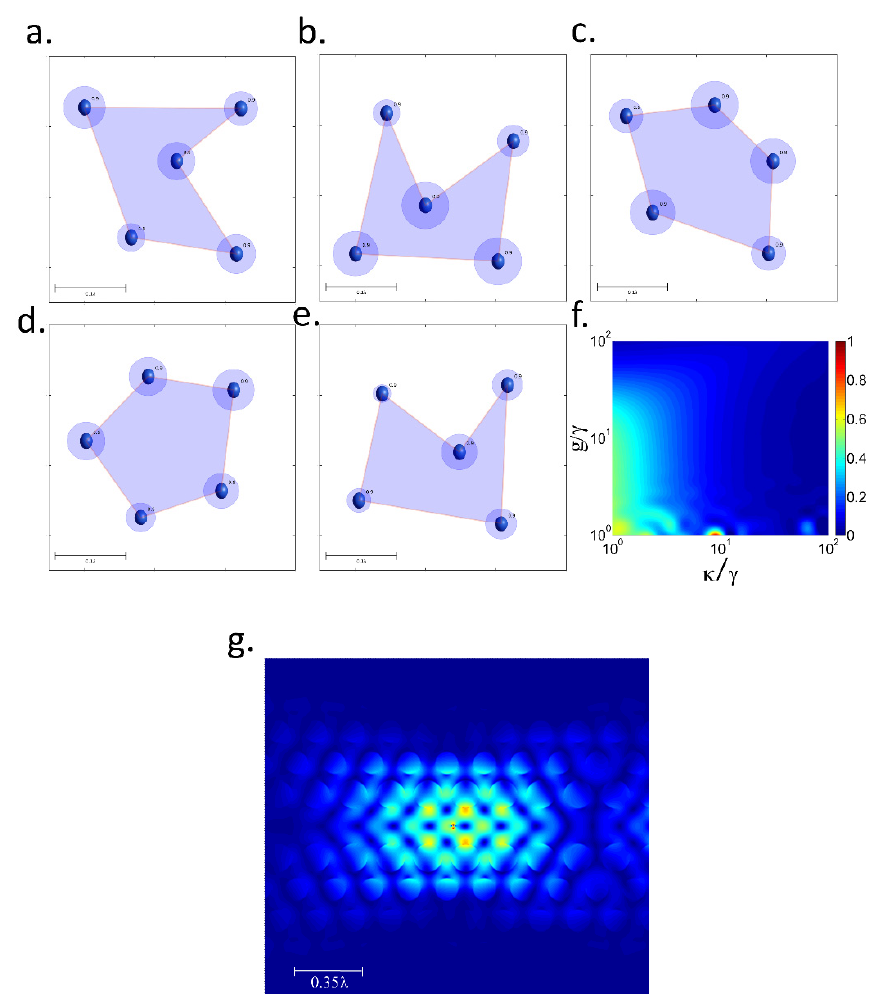
Figure 3. ( a ) Optimal configuration of the 5-QEs system in a 2D plane for ( a ) 𝜅 = 10𝛾 , ( b ) 𝜅 = 50𝛾 , ( c ) 𝜅 = 100𝛾 , ( d ) 𝜅 = 500𝛾 and ( e ) 𝜅 = 1000𝛾 . The circles around each QE position corresponds to the positioning tolerance for having I > 0.9. ( f ) Indistinguishability versus normalized 𝜅 and g for the optimized system shown in ( a ). ( g ) Field profile |𝐸| (cid:2870) of the hexagonal PC-cavity-mode with a point source placed at the antinode.